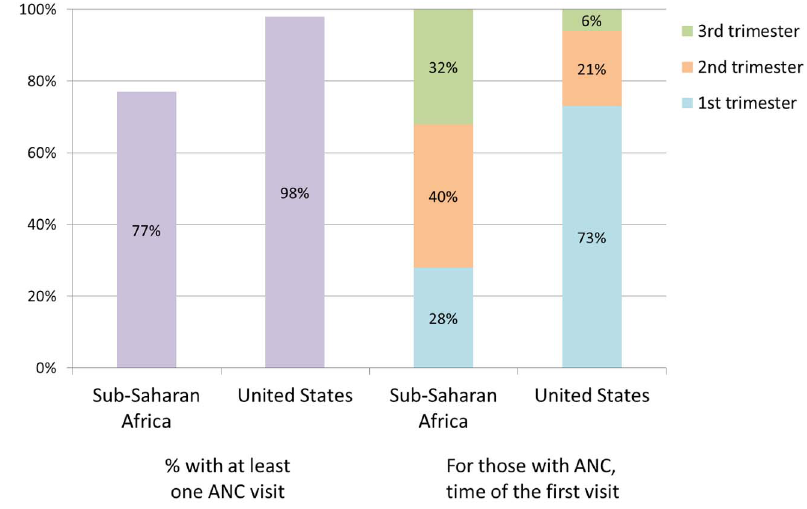
Figure 1. While 77% of women in sub-Saharan Africa have at least one antenatal care (ANC) visit, most are not seen until the second or third trimester [ 34 ] . In contrast, the majority of women in the United States access antenatal care during the first trimester [35].